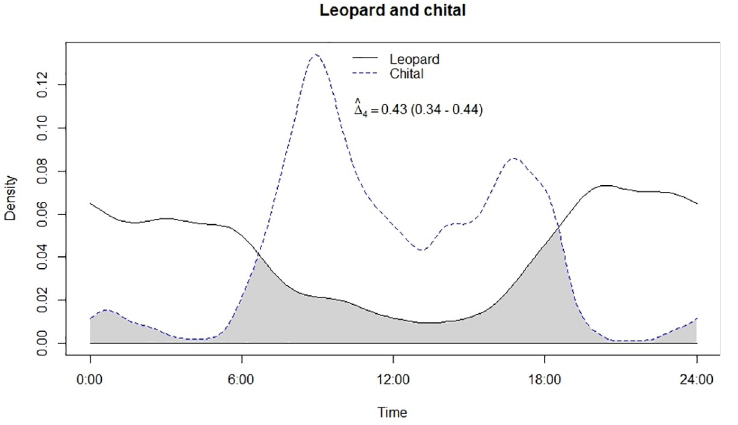
Fig 5. Temporal overlap between leopard and